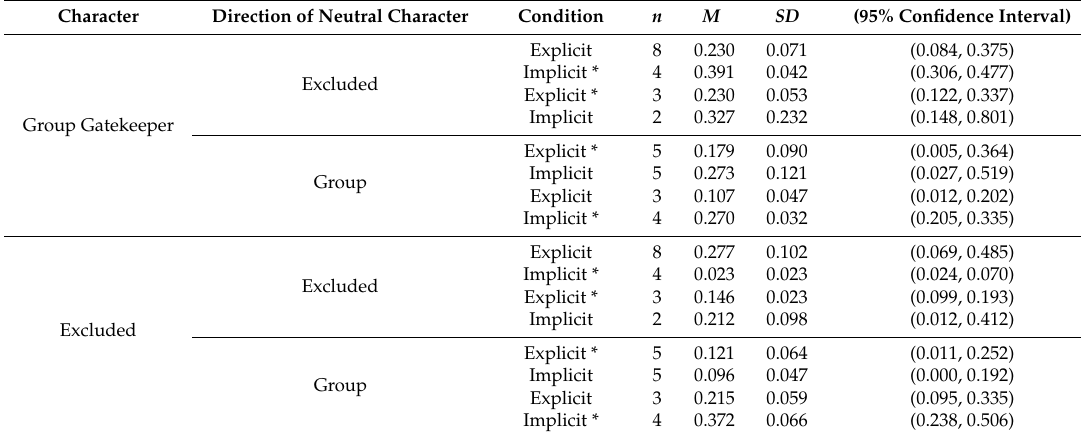
Table 5. Proportions of fixations on primary AOIs at the end of the test